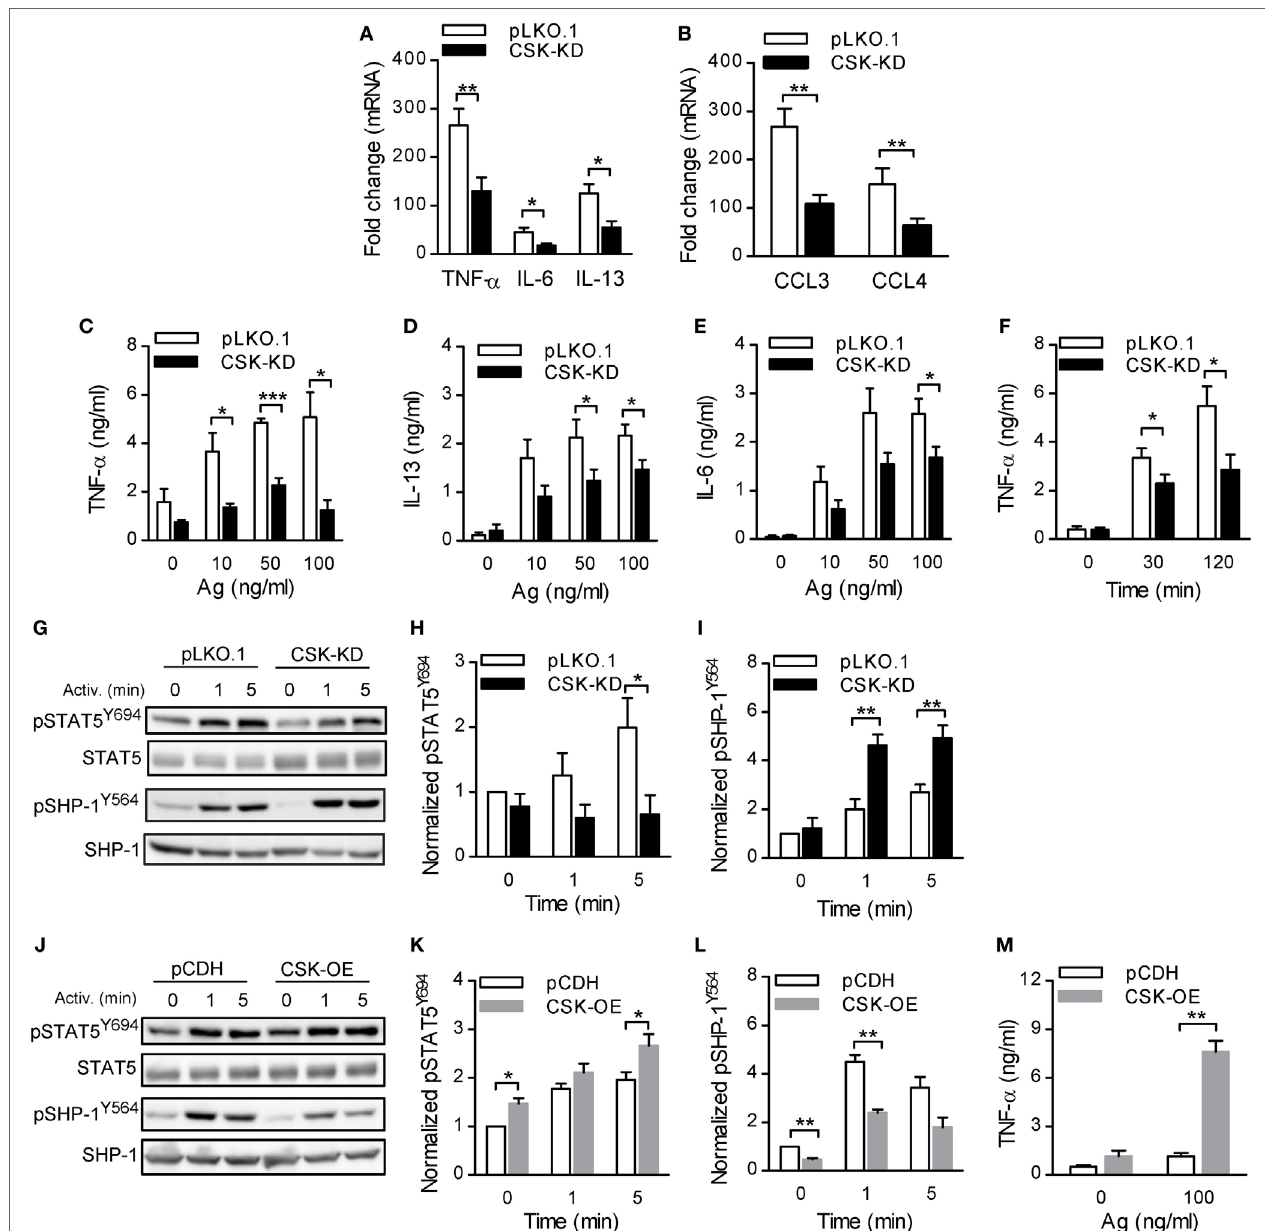
FigUre 4 | Activated bone marrow-derived mast cells (BMMCs) with C-terminal Src kinase (CSK)-KD exhibit reduced cytokine and chemokine production, reduced STAT5 tyrosine phosphorylation, and enhanced SHP-1 tyrosine phosphorylation. (a,B) IgE-sensitized BMMCs with CSK-KD or pLKO.1 control cells were activated for 1 h with antigen (100 ng/ml), and mRNAs encoding cytokines (TNF- α , IL-6, and IL-13); (a) or chemokines (CCL3 and CCL4); (B) were quantified by RT-qPCR. Means ± SEM were calculated from four independent experiments. (c–e) IgE-sensitized BMMCs with CSK-KD or pLKO.1 control cells were activated or not for 6 h with various concentrations of antigen and the concentrations of cytokines TNF- α (c) , IL-13 (D) , and IL-6 (e) secreted into the supernatants were determined. Means ± SEM were calculated from 4–8 independent experiments performed in duplicates or triplicates. (F) The cells were analyzed as in (c) except that they were activated with only one concentration of antigen (50 ng/ml) for 30 or 120 min. Means ± SEM were calculated from four independent experiments performed in duplicates. (g) Representative immunoblots of whole-cell lysates from BMMCs with CSK-KD or pLKO.1 control cells activated for 1 or 5 min or not activated with antigen and analyzed by immunoblotting with antibodies to tyrosine-phosphorylated STAT5 (pSTAT5 Y694 ) and SHP-1 (pSHP-1 Y564 ). For loading controls, the membranes were analyzed by immunoblotting for STAT5 and SHP-1. (h,i) Densitometry analysis of the immunoblots in which signals from pSTAT5 Y694 (h) and pSHP-1 Y564 (i) in activated cells were normalized to the signals from nonactivated control cells and loading control proteins. Means ± SEM were calculated